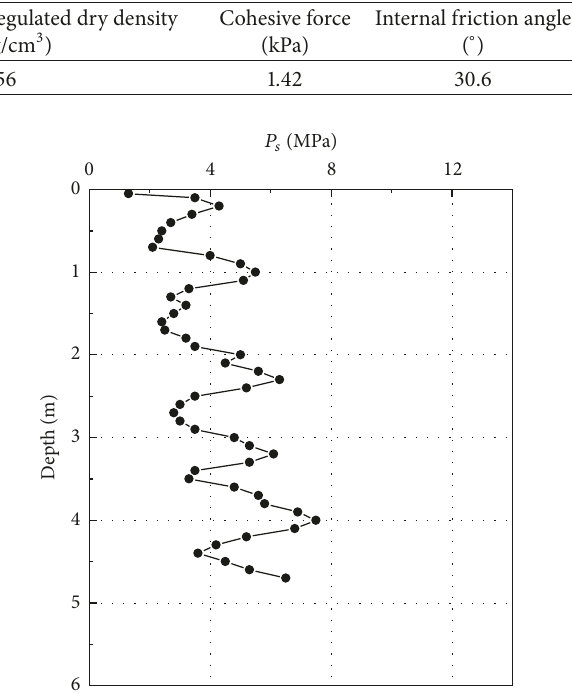
Figure 3: Result of CPT